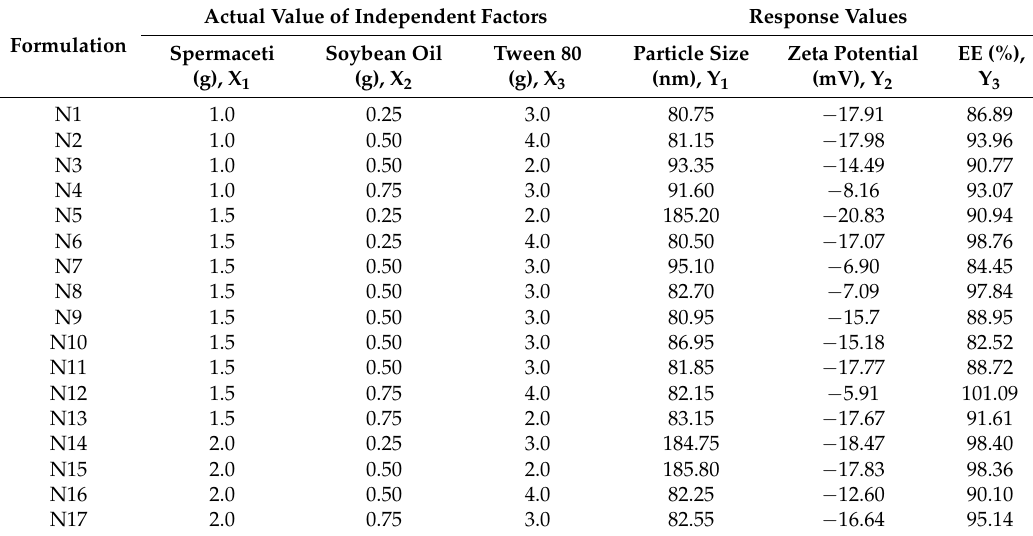
Table 1. The Box–Behnken experimental design and response